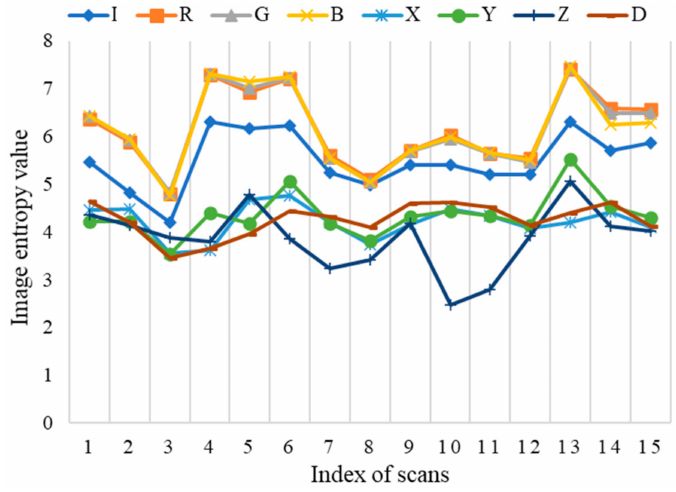
Figure 2. The entropy of different channel